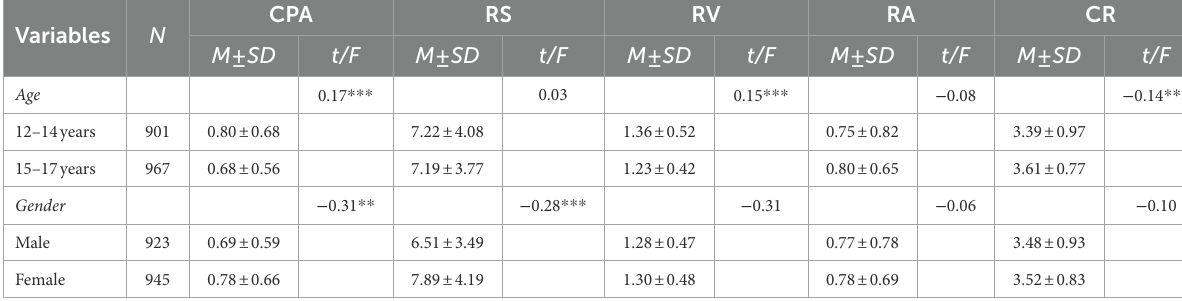
TABLE 1 The independent sample T -test of the gender and age among the model variables.